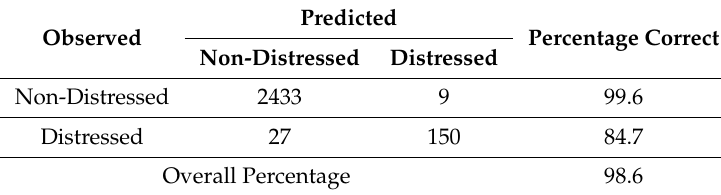
Table 5. Standard logit model—classification table.